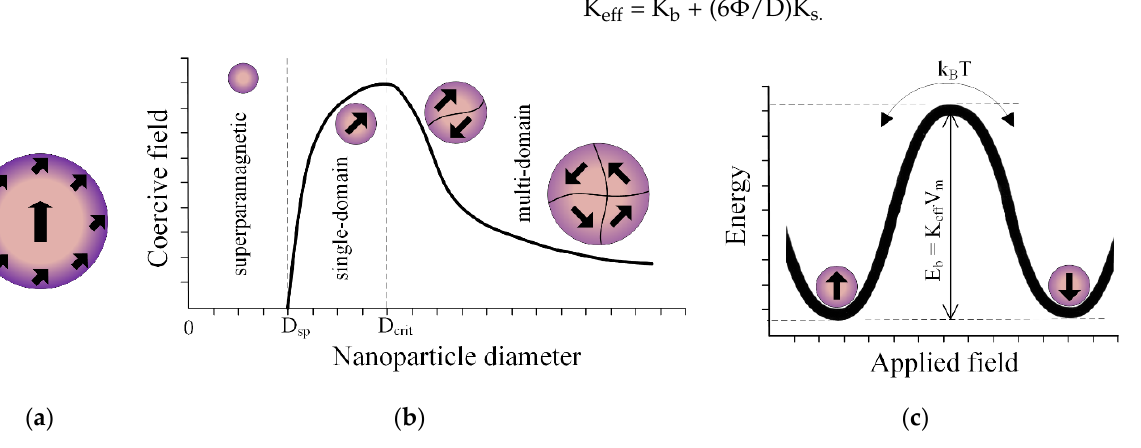
Figure 10. Magnetization processes in MNPs: ( a ) illustration of surface spin-canting effect in MNPs; ( b ) coercive field dependence as a function of nanoparticle diameter; ( c ) nanoparticle energy versus external applied magnetic field.